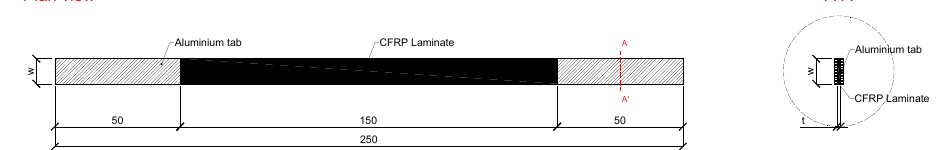
Figure 6. Geometry of the CFRP laminate strip specimens used in the tensile tests. All units in (mm).